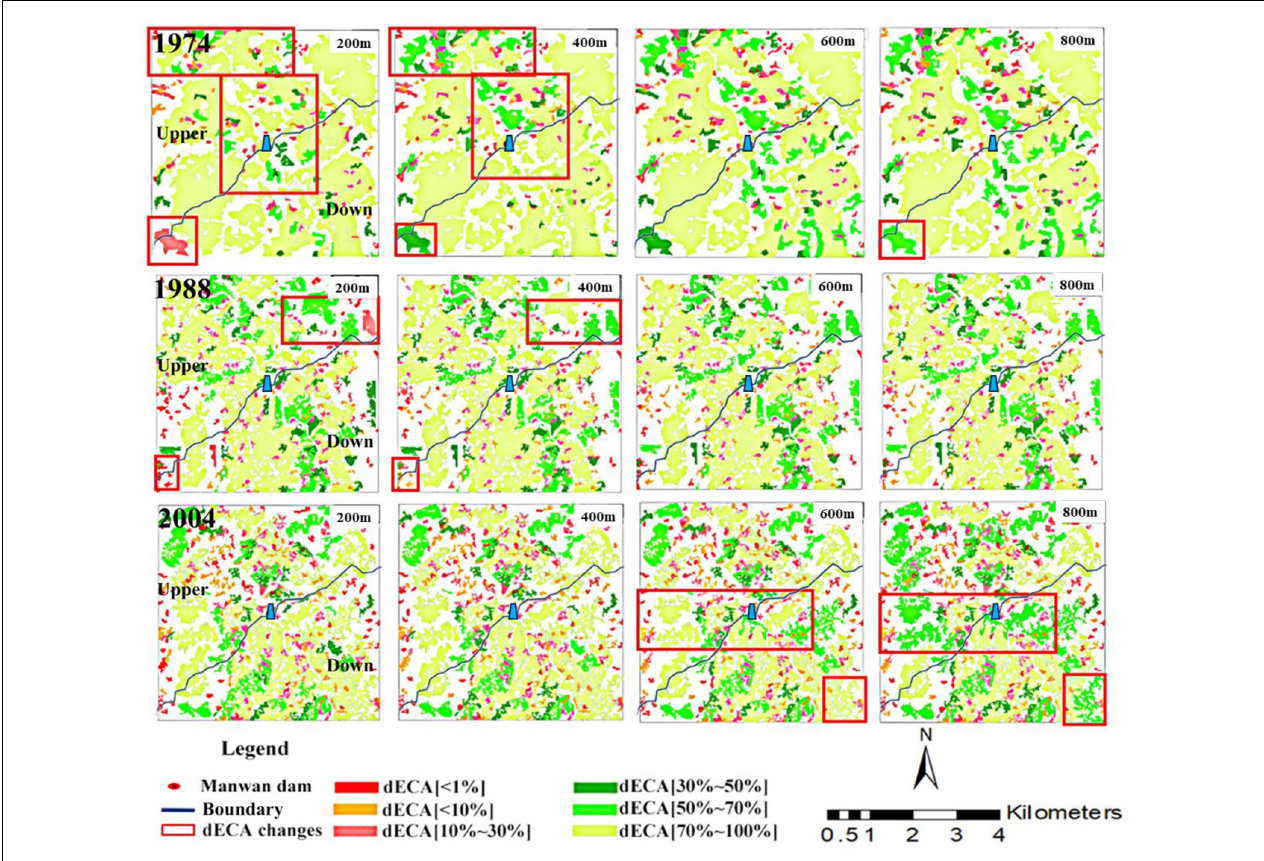
FIGURE 3 | Connectivity changes in the Manwan forest patches under four different dispersal distances in 1974, 1988, and 2004, as measured by the dECA